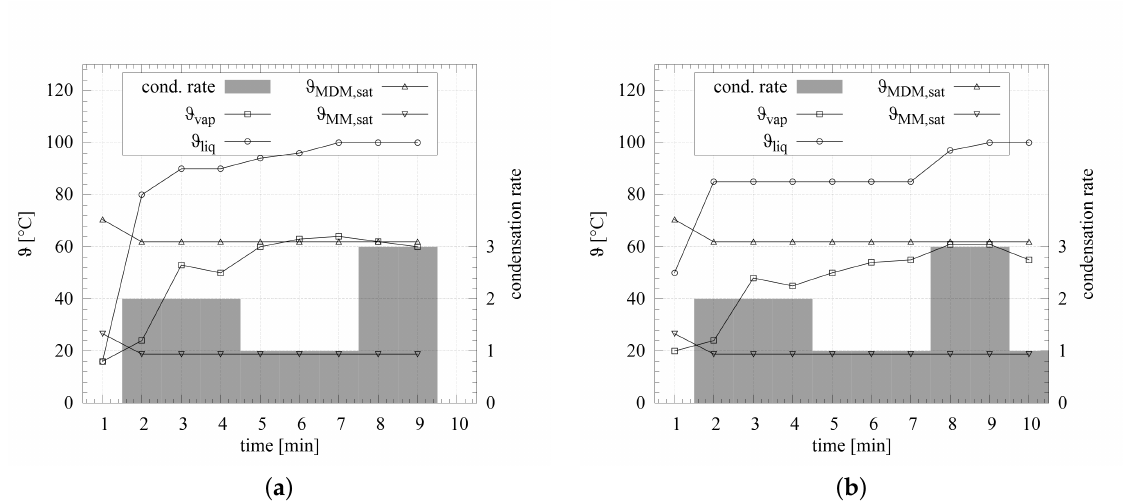
Figure 5. ( a ) Distilling process of Experiment A; ( b ) Distilling process of Experiment B.